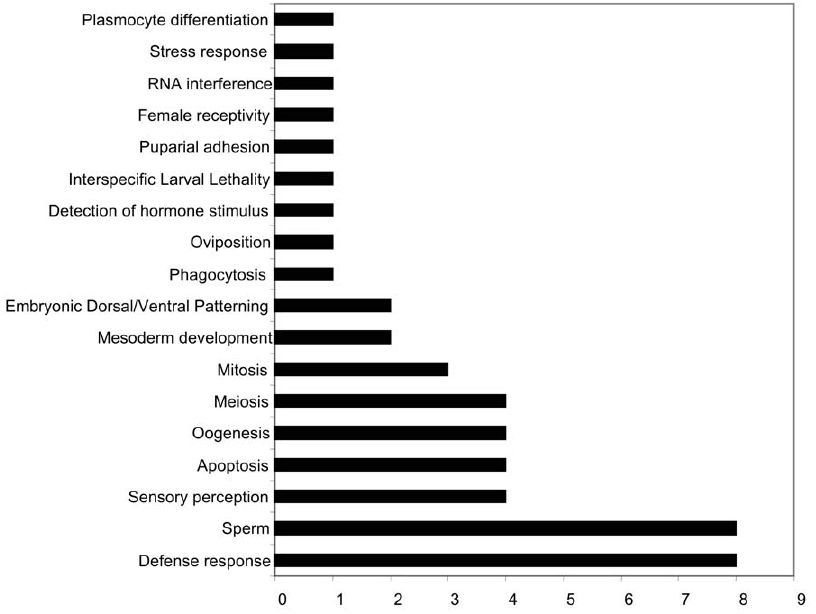
Figure 4. The biological functions of 48 ancestral alleles defined by Gene Ontology. The graph shows only genes with biological functions assigned by assays, inferred by sequence similarity or phenotype and does not include general biochemical properties such as phosphorylation, transcription initiation, signal transduction, proteolysis among others. The complete list of genes can be found in supporting information.